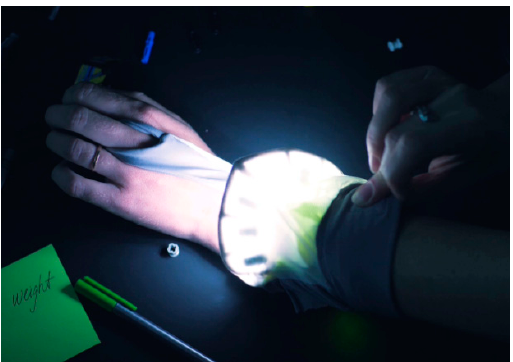
Figure 1. BETAlight worn in public